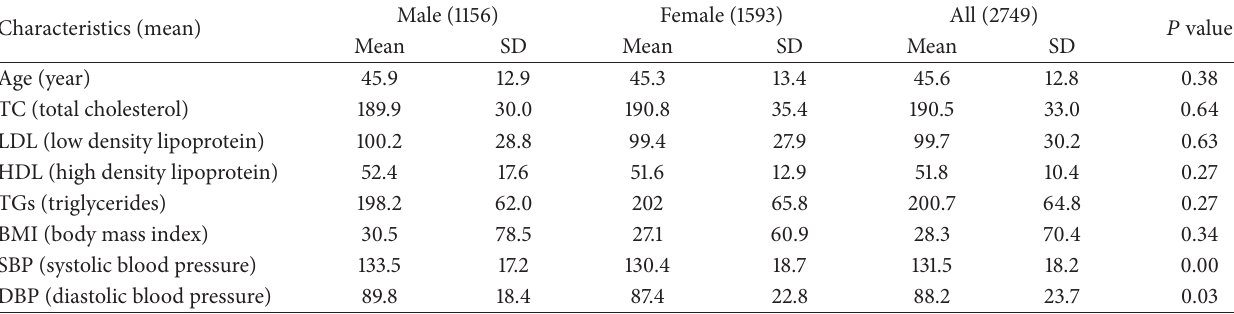
Table 2: Mean level of age, BMI, blood pressure, and lipids of rural cohort for assessment of cardiovascular diseases (CVDs) risk factors in sub-Himalayan region of India, 2011.